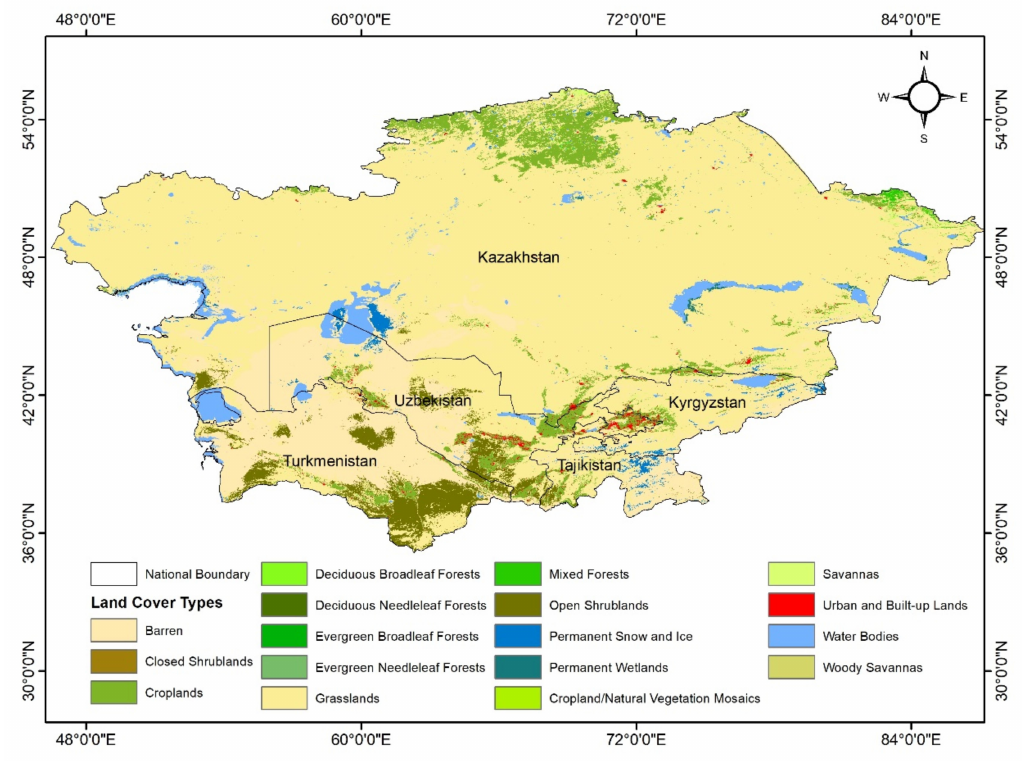
Figure 2. Land cover types of Central Asia in 2018 (source: MODIS MCD12Q1